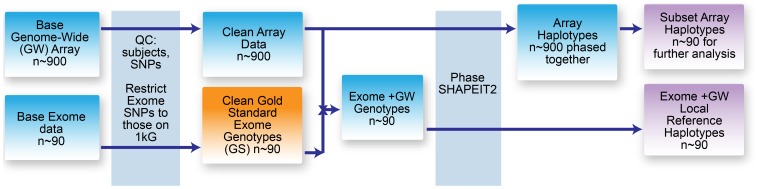
Preparation of array data and local reference panel for imputation.The genotype data were quality controlled and phased. These data were then used in further downstream analysis.